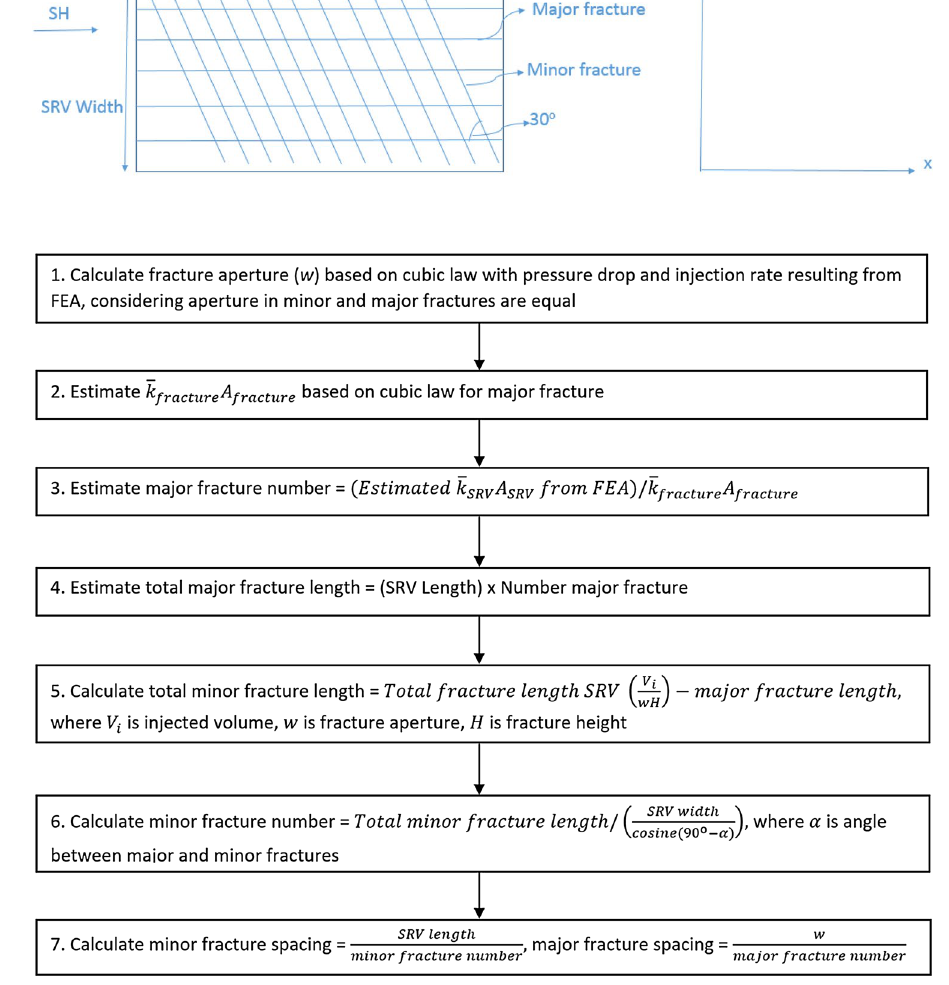
Fig. 15 Top view showing minor and major fractures